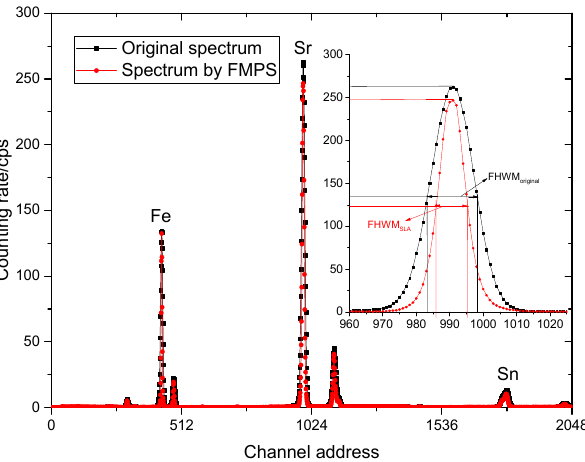
Figure 7. Comparison of the spectra before and after using FMPS.